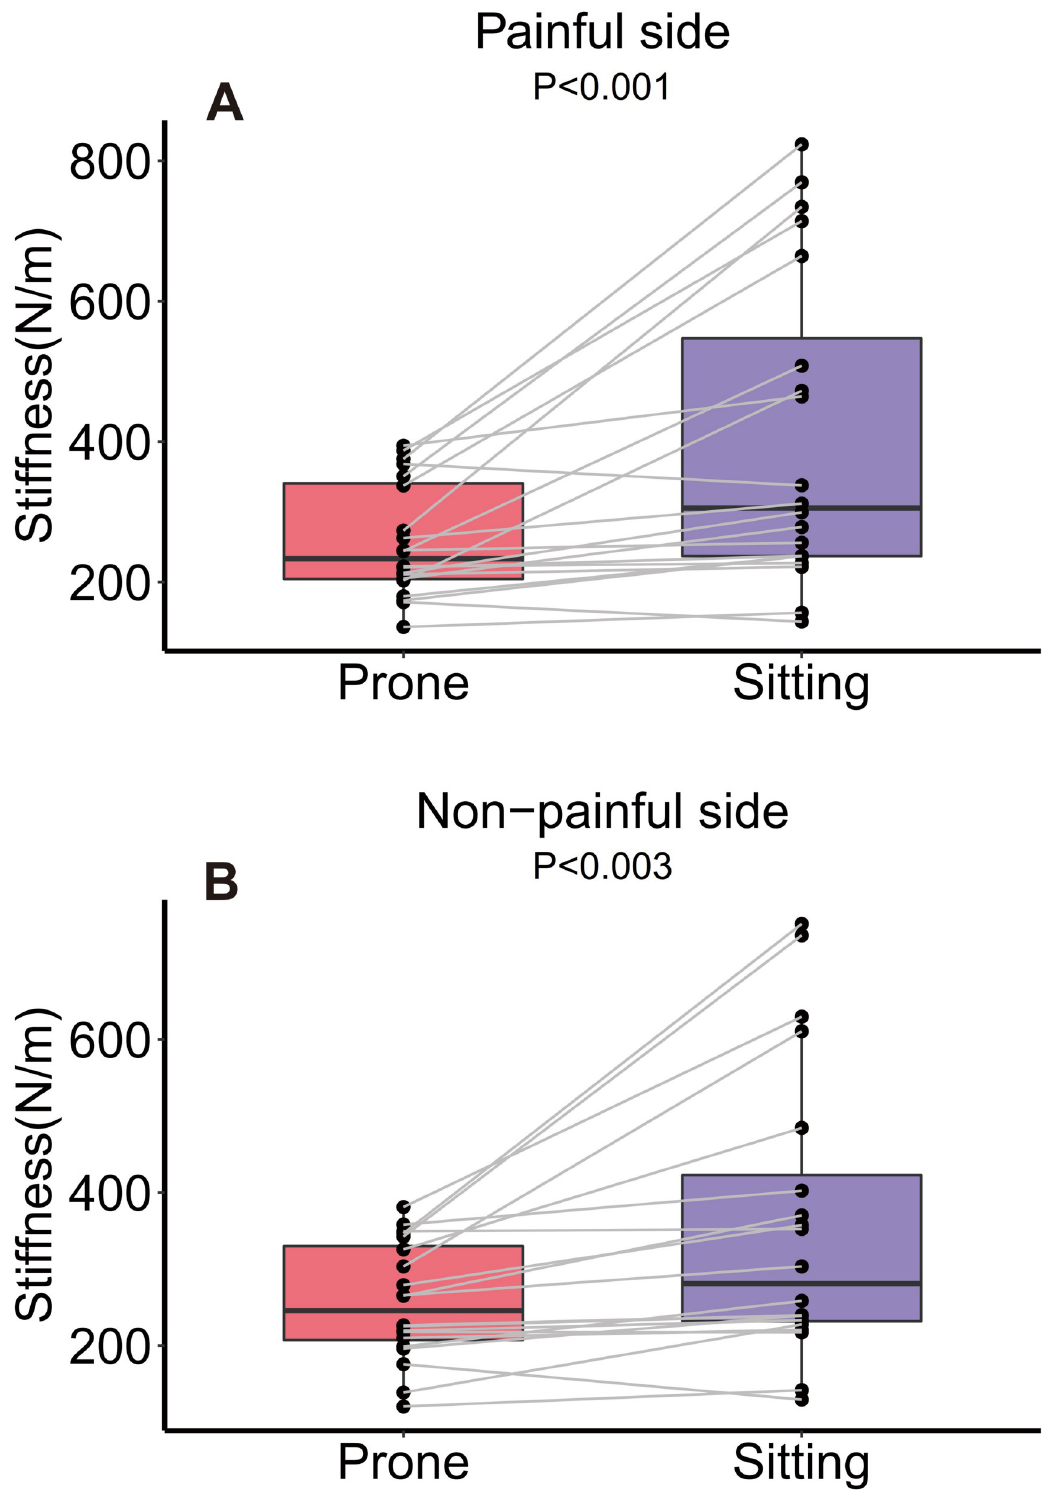
Fig 3. Changes in stiffness of the erector spinae muscle between the painful and non-painful sides from prone to sitting ( N = 20). Values are mean ± SD.